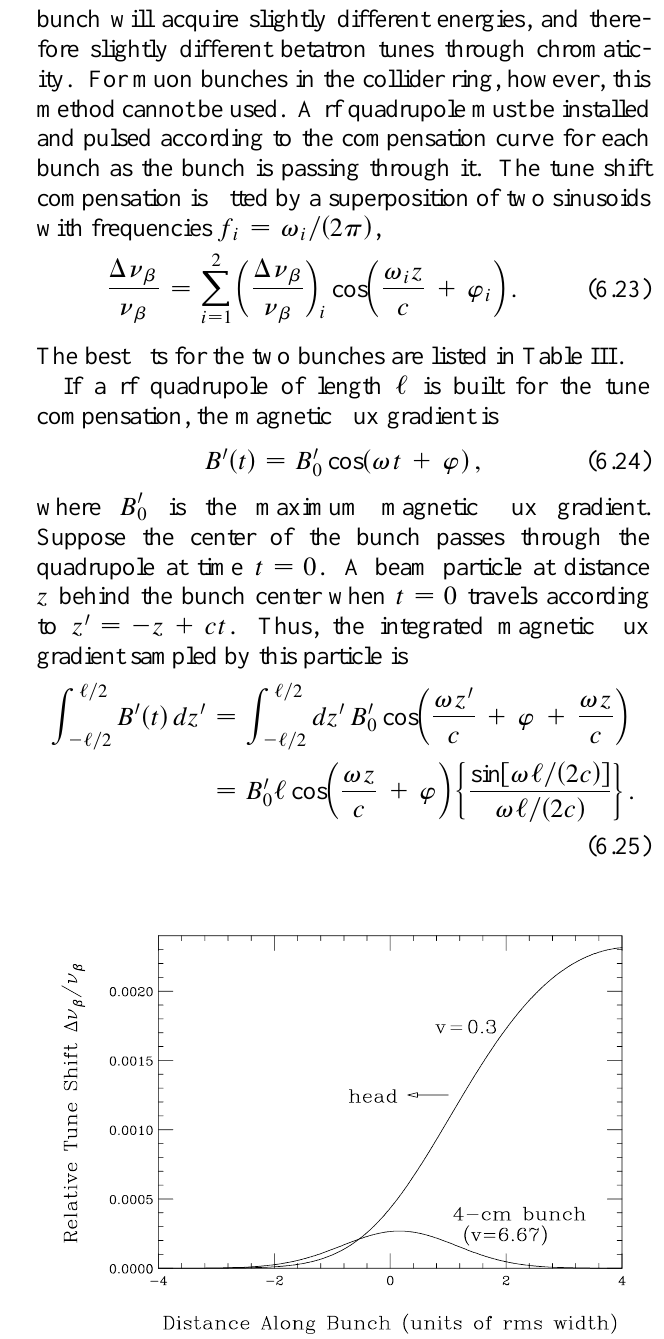
FIG. 20. Relative tune shift compensation for beam particles at distance z (cid:1) s (cid:1) behind the bunch center (or bunch going to the left) to cure beam breakup for a short bunch interacting with a broadband impedance at lower frequency, y (cid:1) v r s (cid:1) (cid:1) c (cid:1) 0.3 . The curve for the 4-cm bunch, where y (cid:1) 6.67 , is plotted for comparison. Note that when y is small, the compensation is more linear, or is of much lower